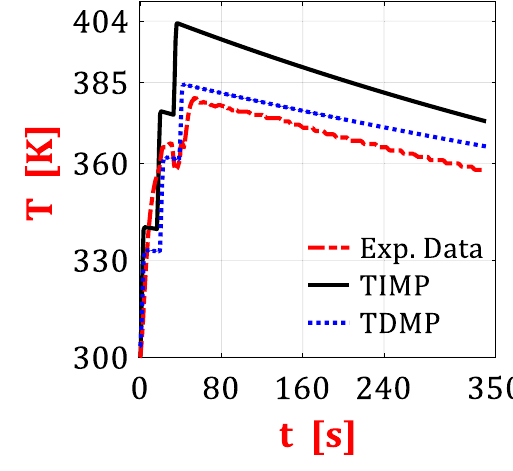
Fig. 21 Temperature–time history of the outer surface of the tem- perature-dependent thick-walled cylinder due to 85 shocks